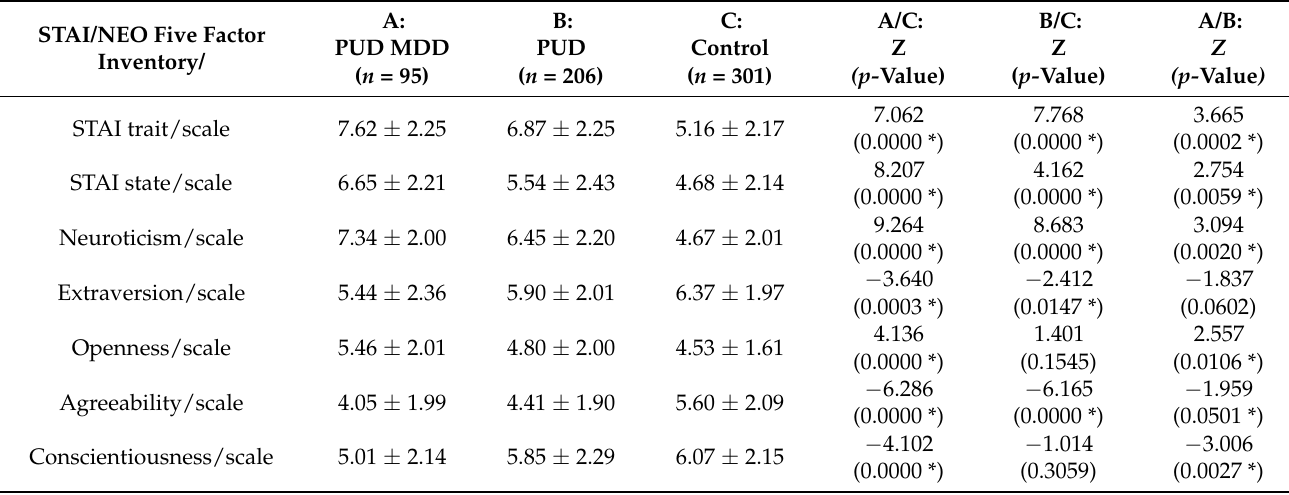
Table 4. STAI and NEO Five Factor Inventory sten scores between healthy controls and all patients diagnosed with polysubstance use disorder comorbid with a depressive episode (PUD MDD)